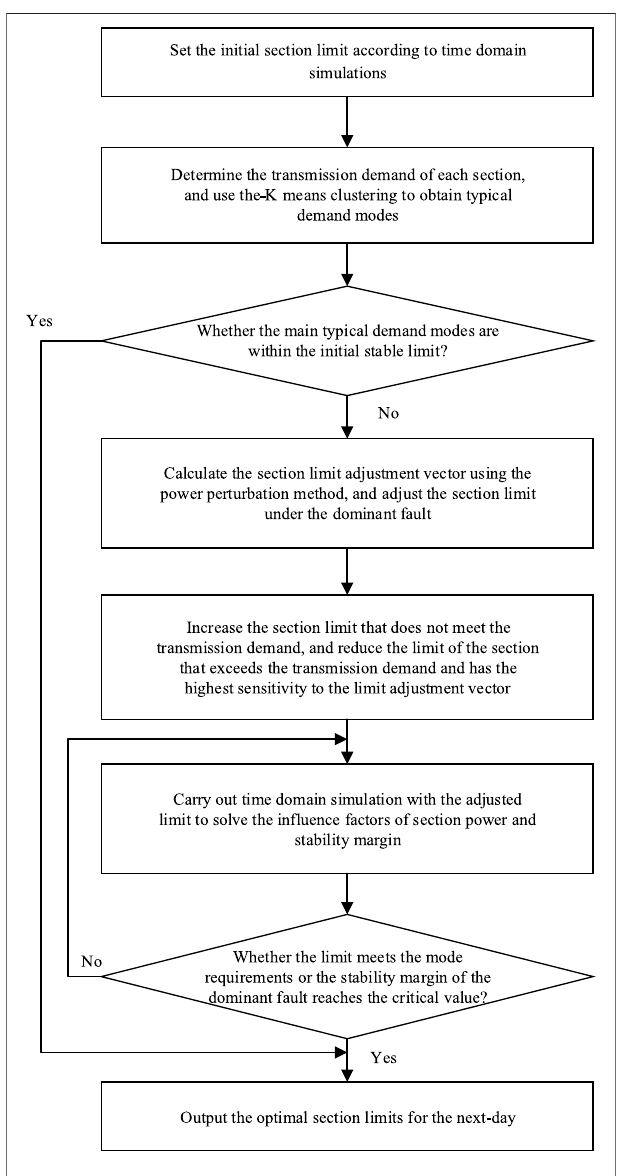
FIGURE 2 | Flowchart of associated transmission section limits optimization